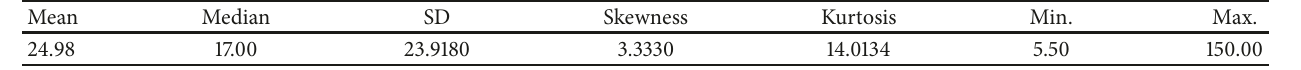
Table 7: Descriptive analysis of the price of urban property data$.